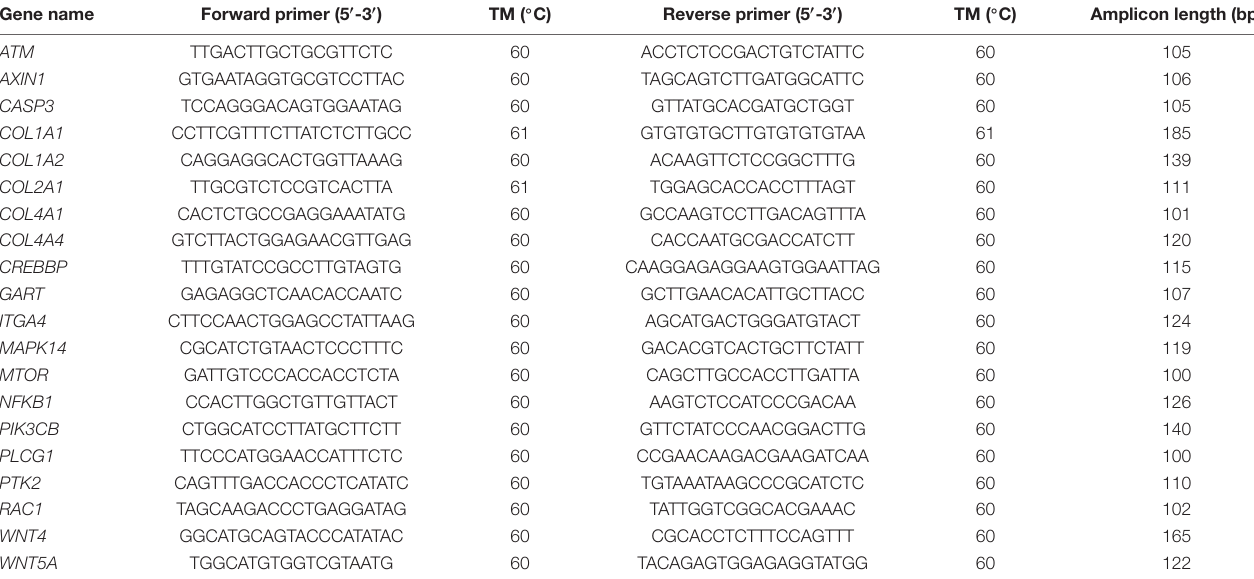
TABLE 1 | Primer list for quantitative RT-PCR verification.